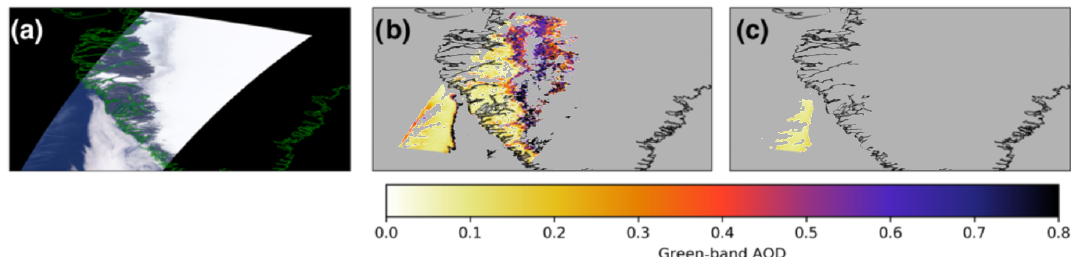
Figure 2. MISR V23 aerosol retrievals over Greenland for 15 August 2017 (orbit 93932, path 006): (a) MISR Ancillary camera RGB, (b) a map of unscreened Aerosol_Optical_Depth_Raw retrievals, and (c) a map of screened Aerosol_Optical_Depth retrievals showing geographic exclusion over land and filtering of lower-quality retrievals over the water.